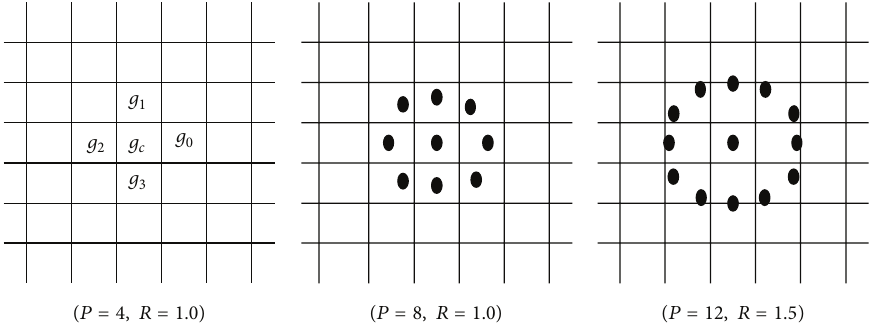
Figure 5: LBP neighbours sets for different ( 𝑃, 𝑅 ) [5, 13].